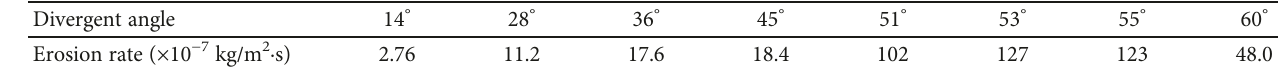
Figure 6: Erosion rate of rock at di ff erent divergent Laval nozzle angles. Table 2: Erosion rate of rock at di ff erent divergent angles.